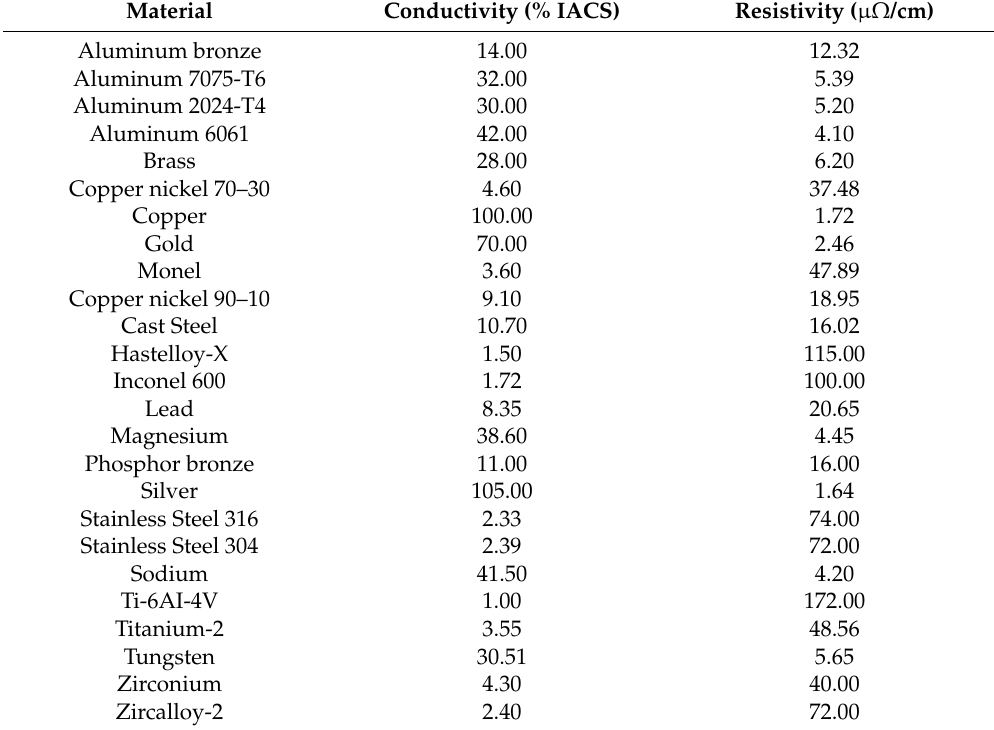
Table 3. Conductivity and resistivity of conductive